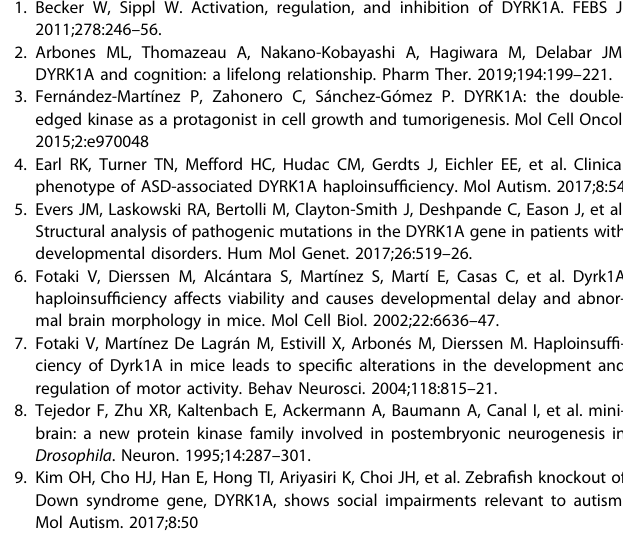
Fig. 8 Working model of TRAF2 – DYRK1A – SPRY2 regulation of EGFR and glioma cell growth. TRAF2 mediates K63-linked ubiquitination of DYRK1A, which leads to its translocation to vesicles, where it interacts with and phosphorylates SPRY2. Phosphorylated SPRY2 negatively regulates the endocytosis and recycling of EGFR, which promotes the growth of glioma